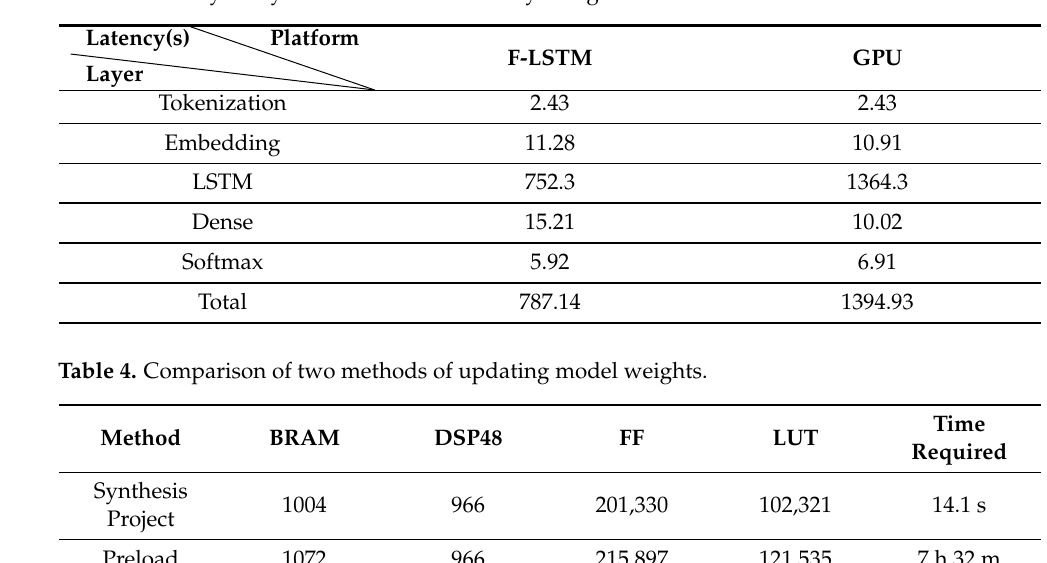
Table 3. Latency of layers in the sentiment analysis algorithm.